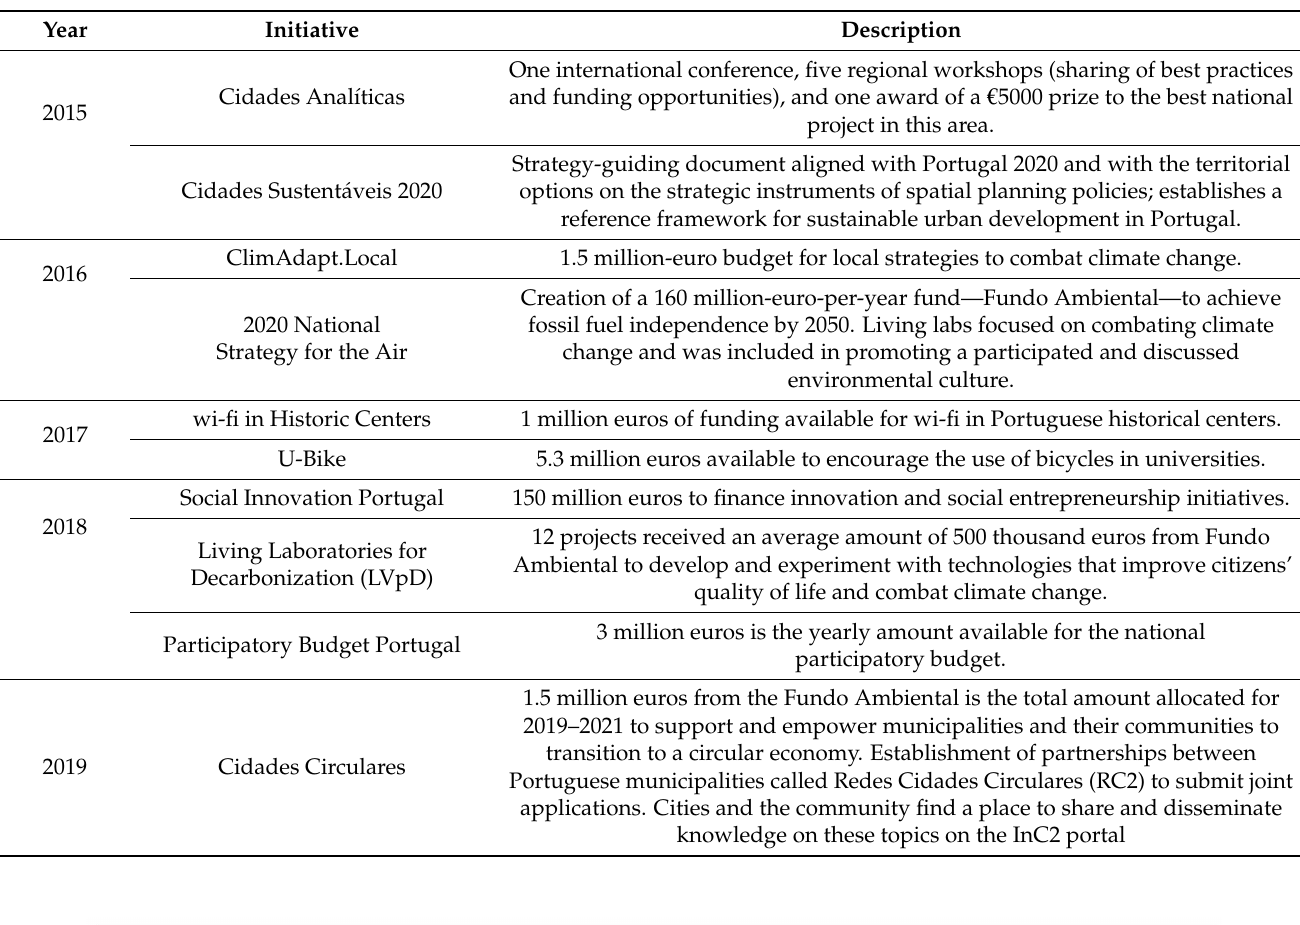
Table 2. Portuguese governmental funding initiatives.